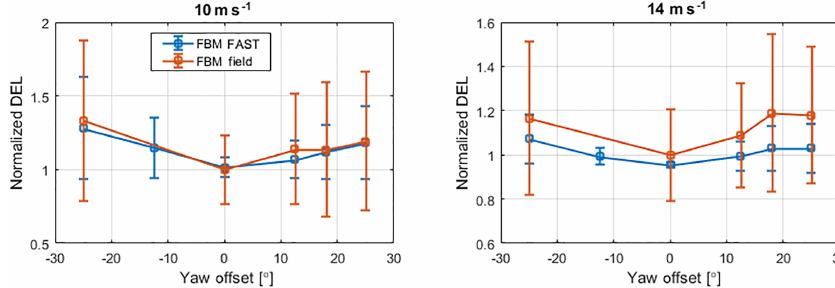
Figure A1. Comparison between predicted (FAST) and measured (field) FBM DELs.